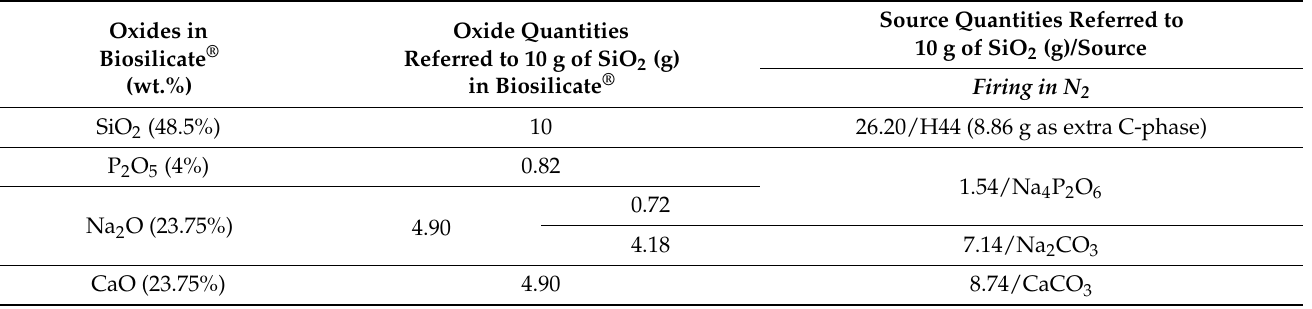
Table 3. Batch formulation for polymer-derived Biosilicate scaffolds shaped by